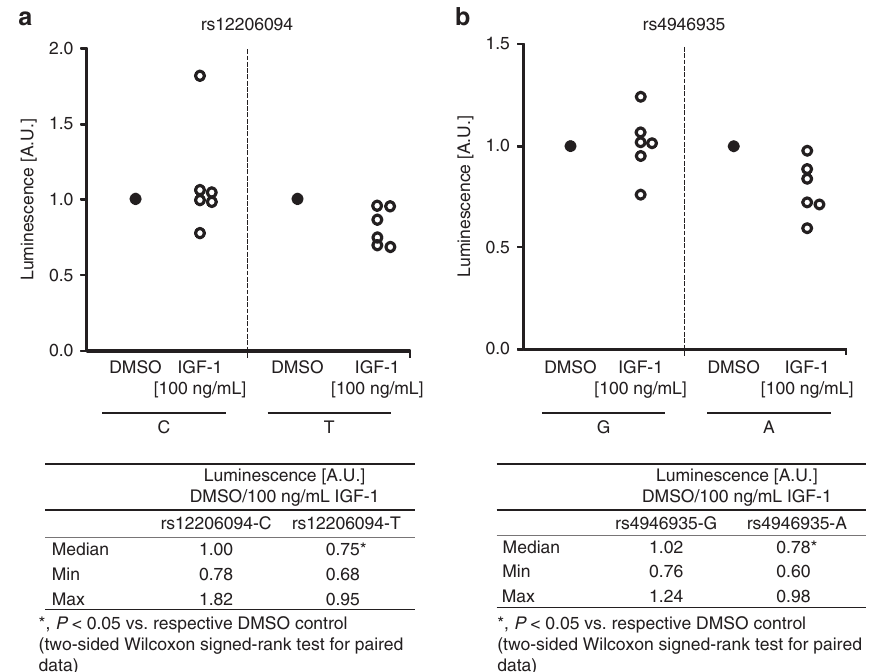
Fig. 4 IGF-1 treatment reduces luciferase promoter activity in the presence of the longevity alleles of rs12206094 and rs4946935, respectively. a , b Luciferase promoter assays were perfomed in Panc1 cells transfected with allele-speci fi c constructs for rs12206094 ( a ) and rs4946935 ( b ). The activity of cells treated with DMSO as control instead of IGF-1 was set = 1 (black dot) for each allele of each SNV. Each white dot represents one independent experiment ( n = 6). Final DMSO concentrations did not exceed 0.1%. The tables below the fi gures show the median as well as the minimum and maximum values for the ratios of the activity in presence of DMSO and 100 ng/mL IGF-1 for each allele, taking into account all experiments. For determination of speci fi c luciferase activity, activity of the fi re fl y luciferase was normalized to the activity of the renilla luciferase. P ≤ 0.05 was considered statistically signi fi cant (two-sided Wilcoxon signed-rank test for paired data). A.U., arbitrary luminescence